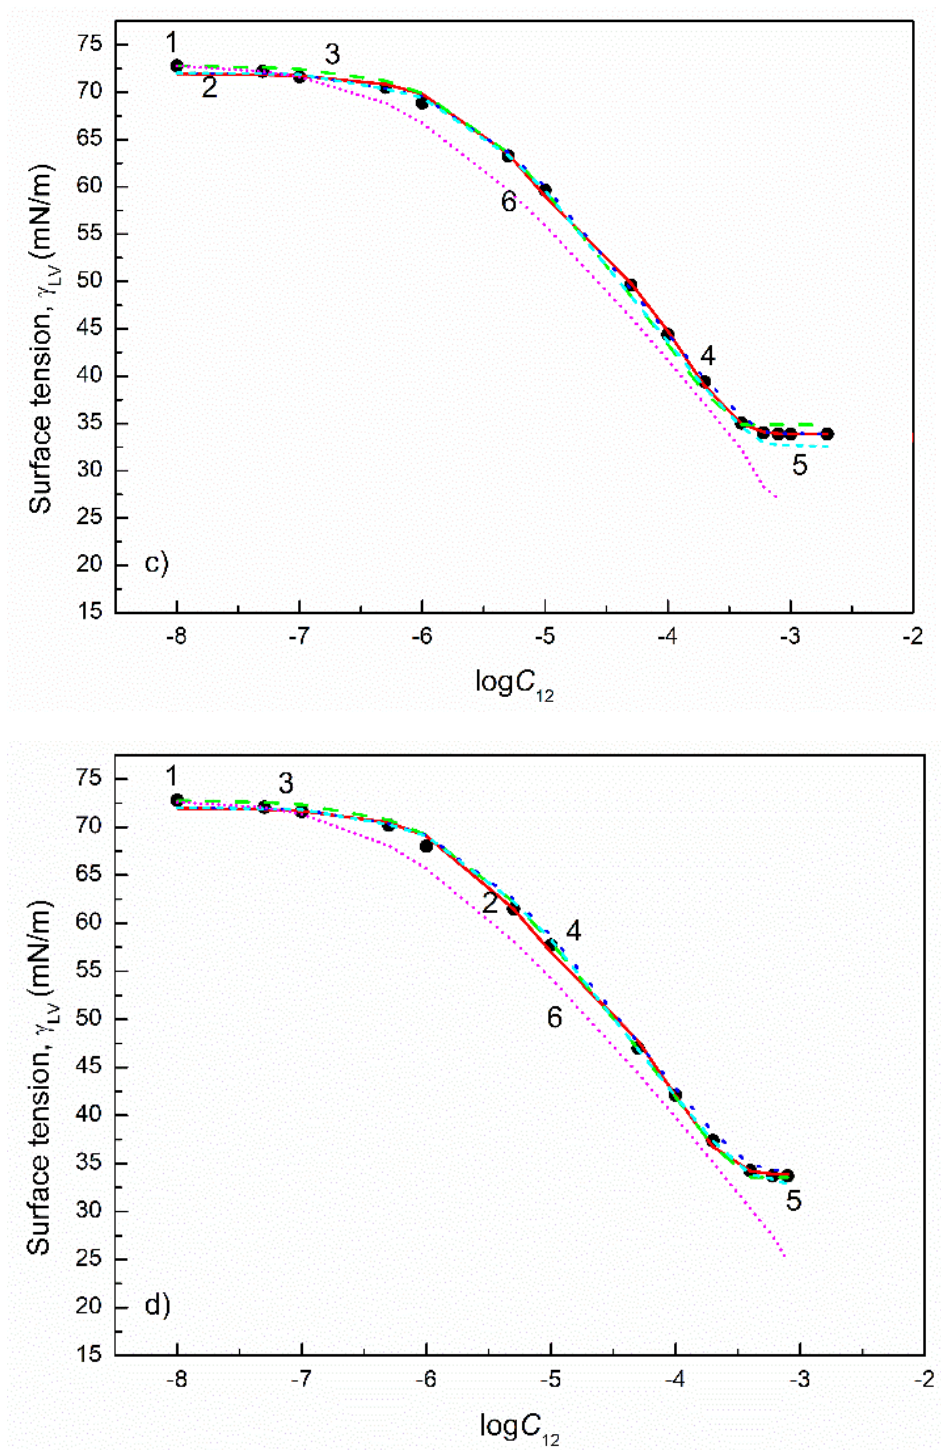
Figure 10. A plot of the surface tension ( γ LV ) of the aqueous solutions of SDDS+TX100 mixtures at the TX100 mole fraction in the bulk phase ( α ) equal to 0.2 ( a ), 0.4 ( b ), 0.6 ( c ) and 0.8 ( d ) vs. the logarithm of the mixture concentration ( logC 12 ). Points 1 correspond to the measured values [28], curves 2 – 6 correspond to the values calculated from the exponential function of the second order (Equation (2)), Szyszkowski equation (Equation (3)), Fainerman and Miller equation (Equation (11)), independent adsorption (Equation (10)) and Joos equation (Equation (13)), respectively.